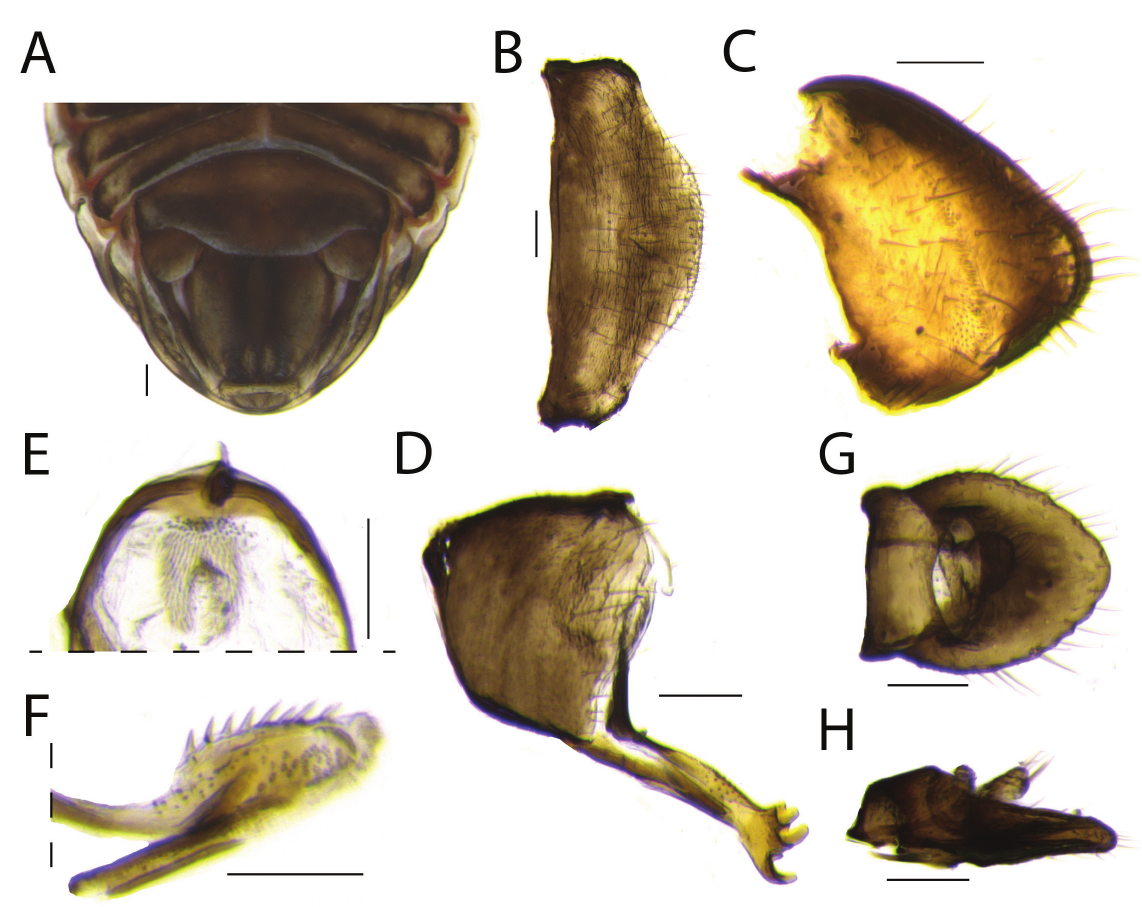
Fig. 20. Female terminalia of Protrocha nesolitaria (Caldwell, 1945), ♀ (INHS). A . External female terminalia, ventral view. B . Sternite VII, ventral view. C . Gonoplac, lateral view. D . Anterior connective lamina of gonapophysis VIII, ventral view. E–F . Posterior connective lamina of gonapophysis IX. E . Connective part in dorsal view. F . Distal part in lateral view. G–H . Anal tube. G . Dorsal view. H . Lateral view. Scale bars = 0.1